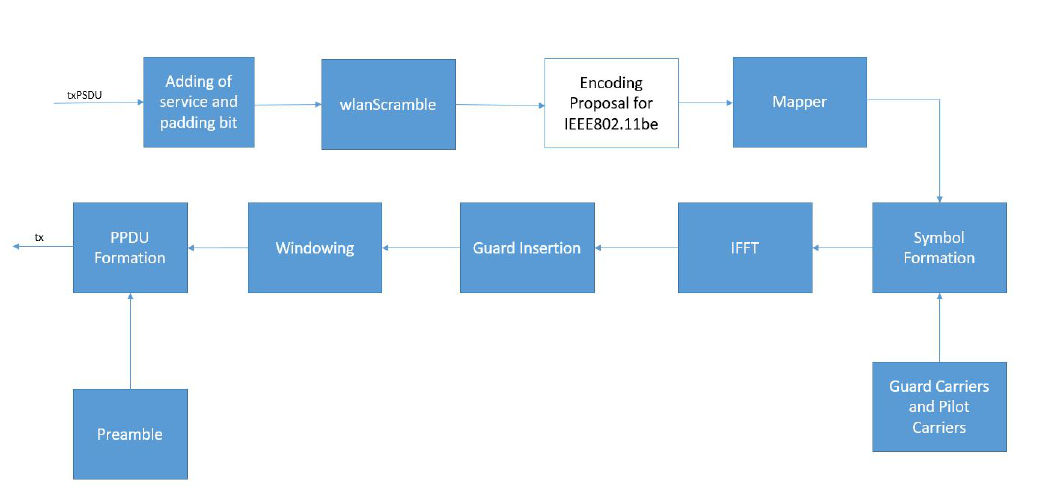
Figure 3. wlanWaveform structure.